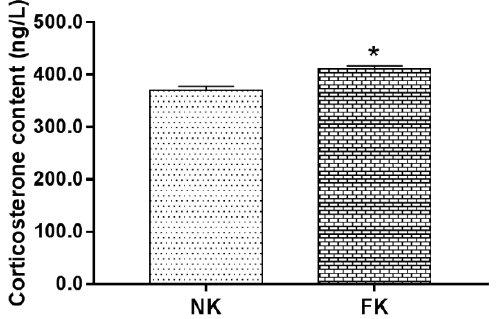
Figure 1. The concentration of serum corticosterone of laying hens with normal keel (NK) or fractured keel (FK). * p ≤ 0.05.